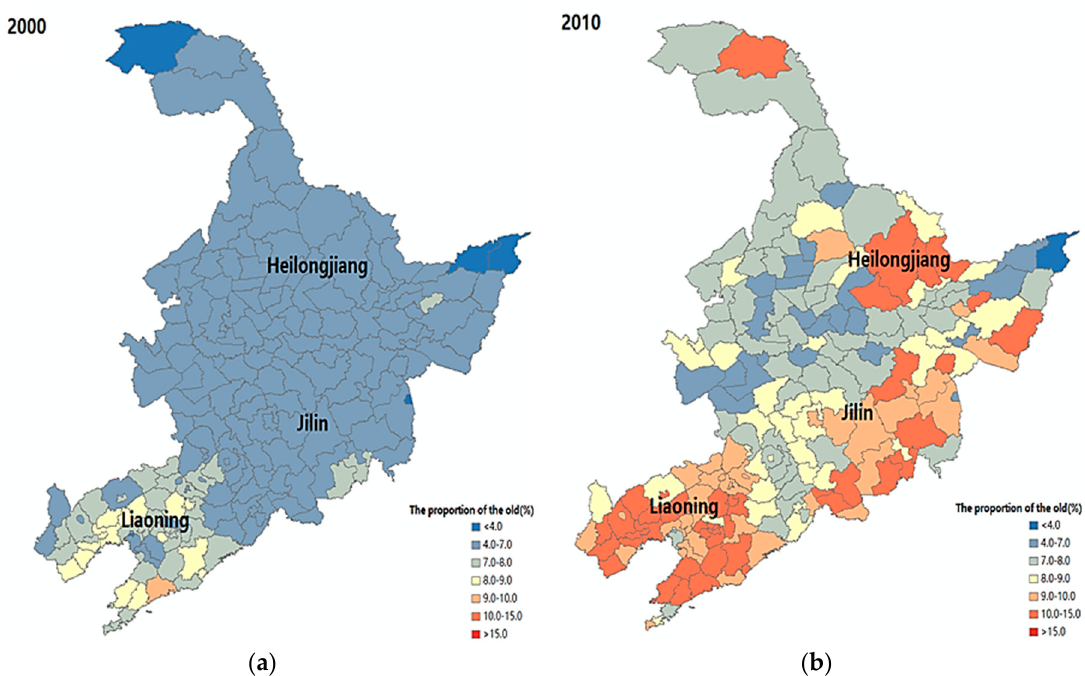
Figure 2. Ageing index of the cities in northeast China. ( a ) Year 2000; ( b ) Year 2010. Int. J. Environ. Res. Public Health 2019 , 16 , 4265